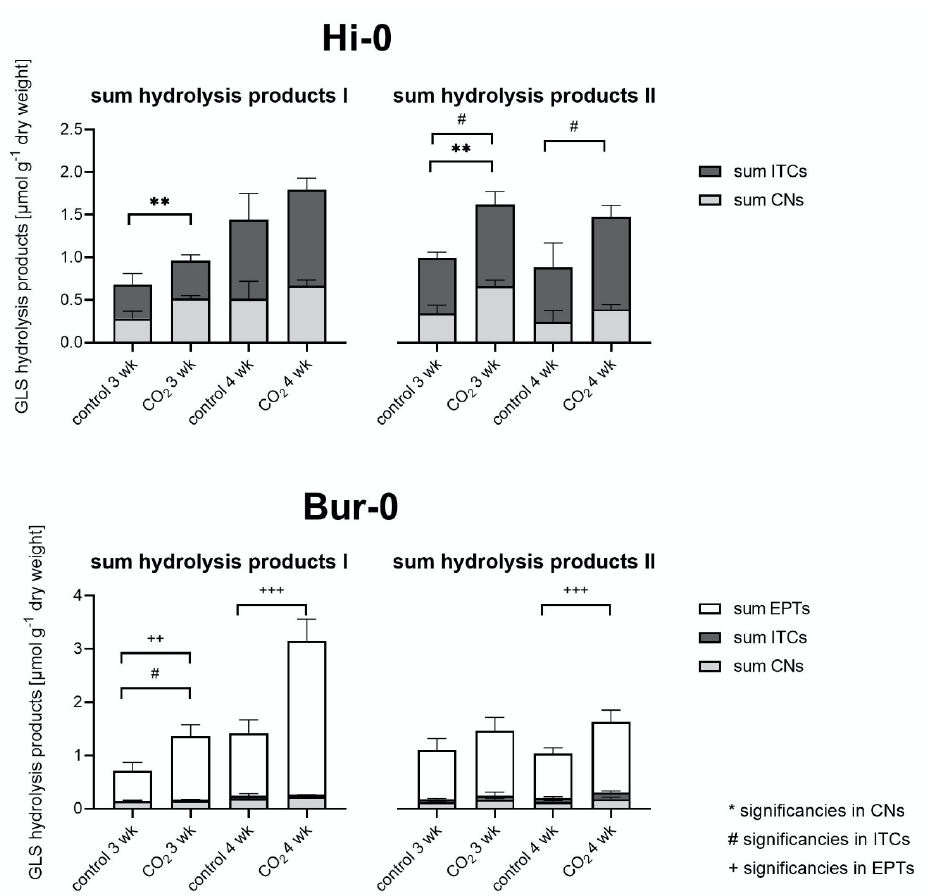
Fig. S2: Effect of elevated CO 2 on the sum of glucosinolate (GLS) hydrolysis products. Hi-0 and Bur-0 after CO 2 treatment (2%) for three or four weeks (wk) compared to ambient air (control). Averages and standard deviations of biological replicates (n = 4-5) are shown for two experimental replications (I and II) separately. Significant differences are marked with symbols (*, #, +, §; for example *, p < 0.05; **, p < 0.01; ***, p < 0.005; unpaired t -test). CNs: nitriles, ITCs: isothiocyanates, EPTs: epithionitriles